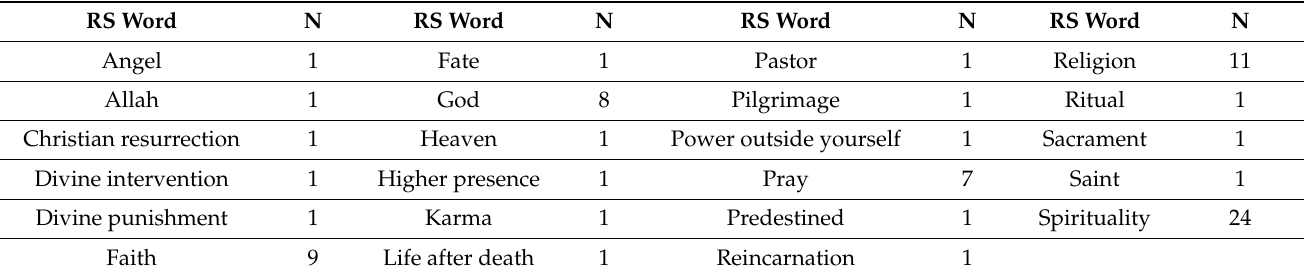
Table 3. List of religious or spiritual words used in the included